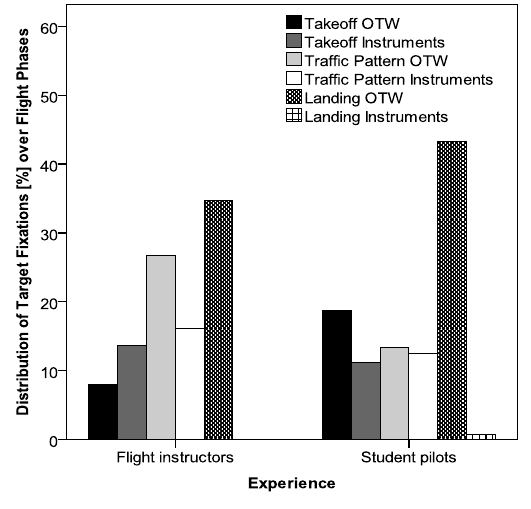
Figure 11. Relative Amount of Target Fixations for